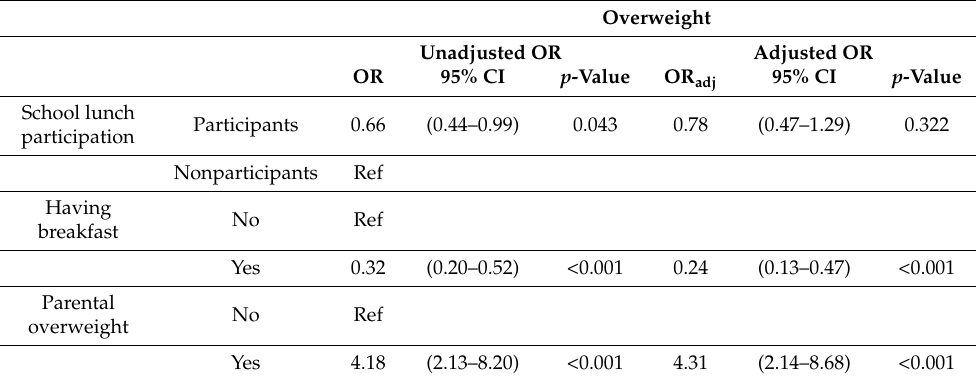
Table 7. Associations between risk of being overweight ( n = 808) and school lunch participation. Effects are given as odds ratios (95%